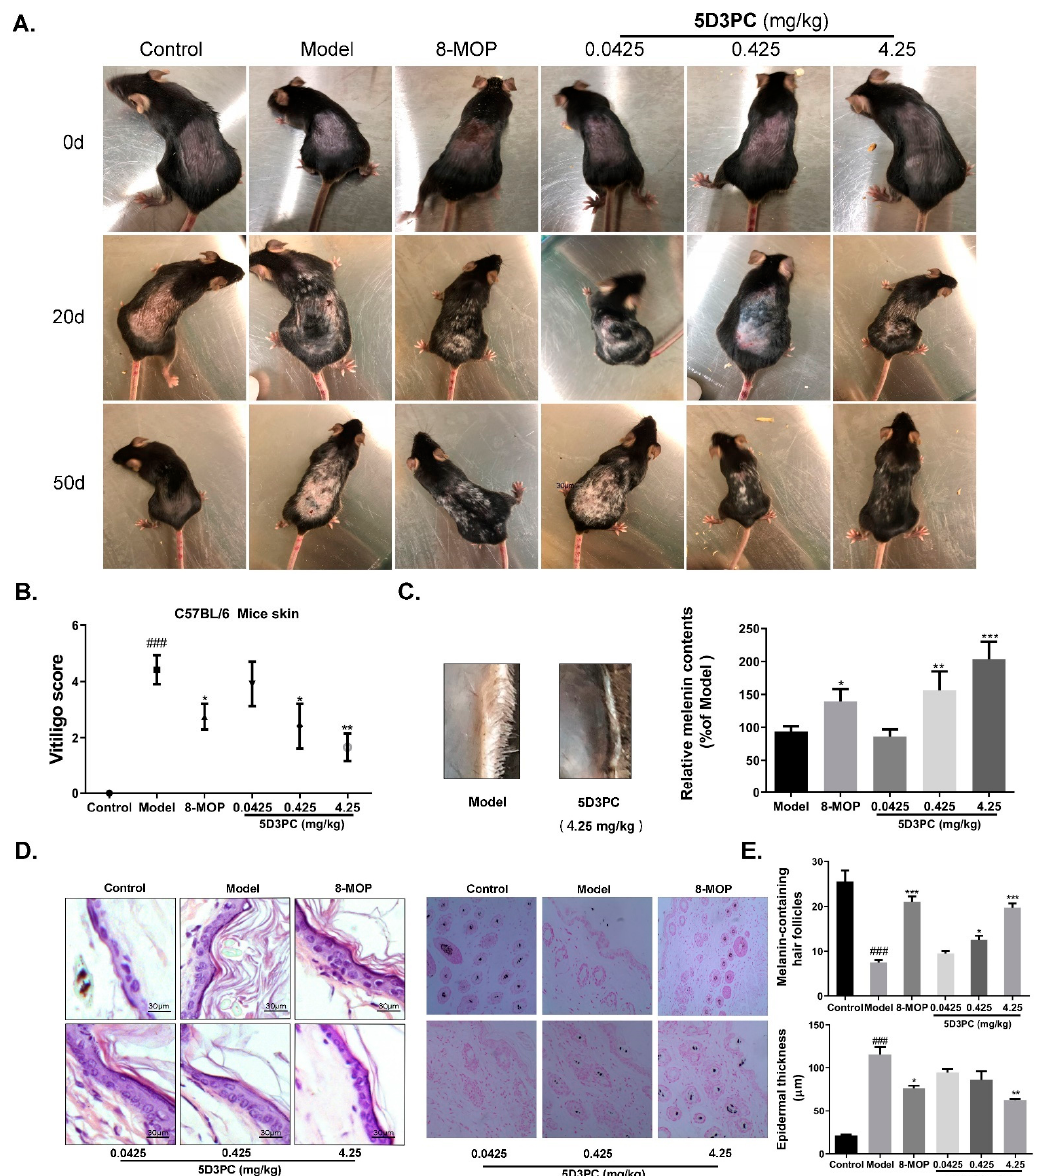
Figure 3. 5D3PC ameliorates C57BL/6 mice model of hydroquinone-induced vitiligo. ( A ) Effect of 5D3PC on C57BL/6 mouse model; presentation of phenotype of mice from control, hydroquinone, and 5D3PC groups, respectively. Photograph is taken after 0 days of experiments, 20 days after hydroquinone induce model, and after 30 days of treatment. ( B ) The degree of depigmentation was scored blindly after 30 days. ( C ). Melanin content in skin tissue treated with different concentrations (0.0425, 0.425, and 4.25 mg/kg) 5D3PC. ( D ).H&E staining of C57BL/6 mice skin oral administration with vehicle, 8-MOP(4.25 mg/kg) or 5D3PC (0.0425 mg/kg, 0.425 mg/kg, 4.25 mg/kg). ( E ) the numbers of melanin-containing hair follicles in mouse dorsal skin by Lillie-stained. Quantification of melanin containing-hair follicles. All results are expressed as mean ± SD; statistical analysis was performed with one-way ANOVA, followed by Tukey’s multiple comparisons test. ### p < 0.001 compare with control group. * p < 0.05, ** p < 0.01, and *** p < 0.001 compared with Model